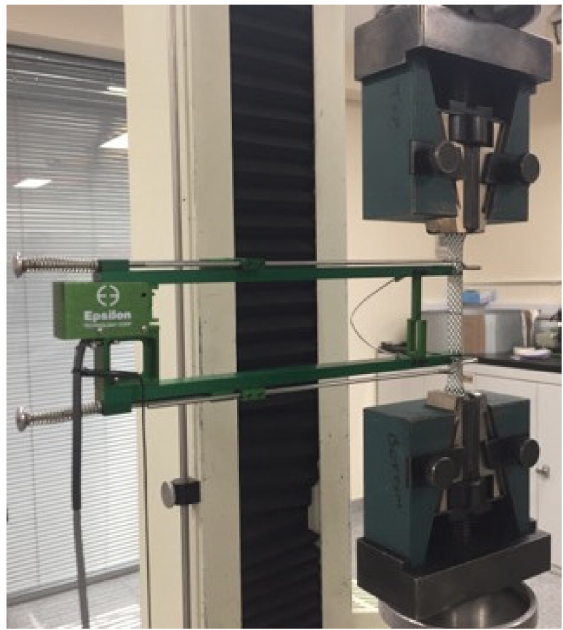
Figure 7. Tensile test